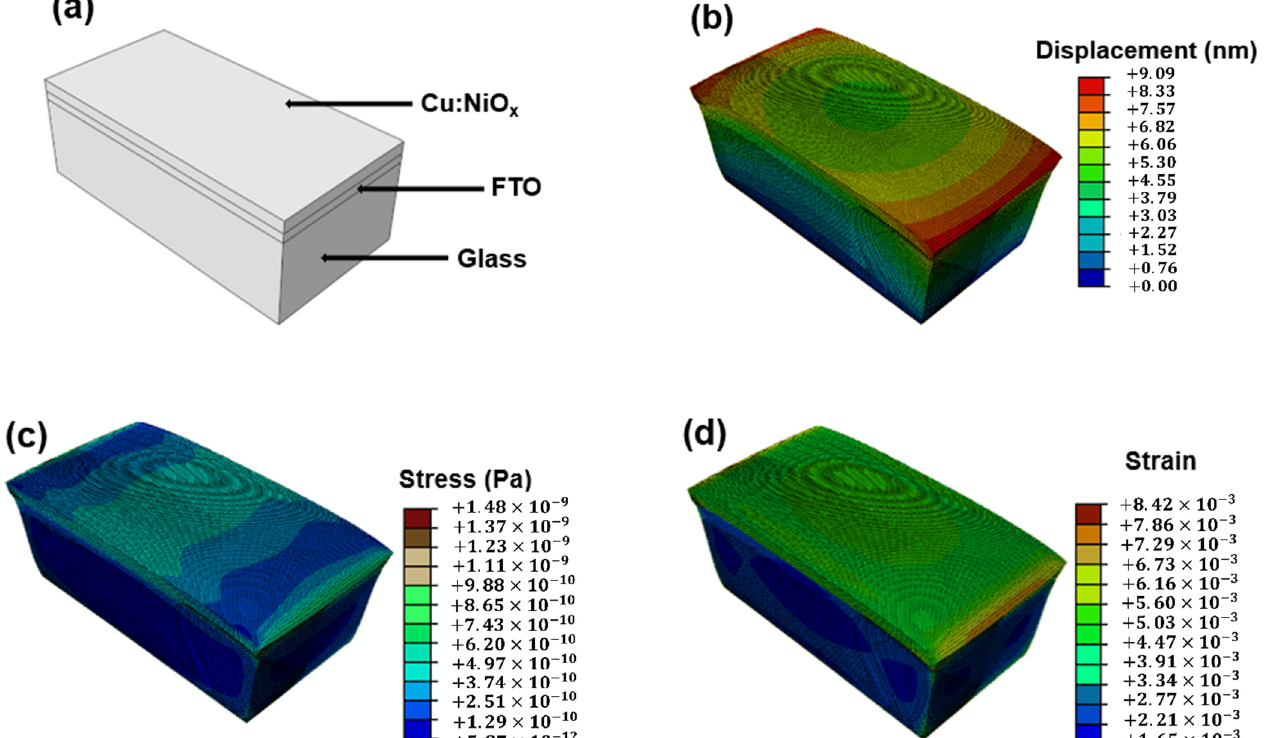
Figure 3. ( a ) Partitioned Cu:NiO x /fluorine-doped tin oxide (FTO)/glass multilayer. ( b ) Deformation of multilayer after annealing at 400 °C. ( c ) Mises stress values for the structure at 400 °C. ( d ) Strain contour plot on multilayers at 400 °C.